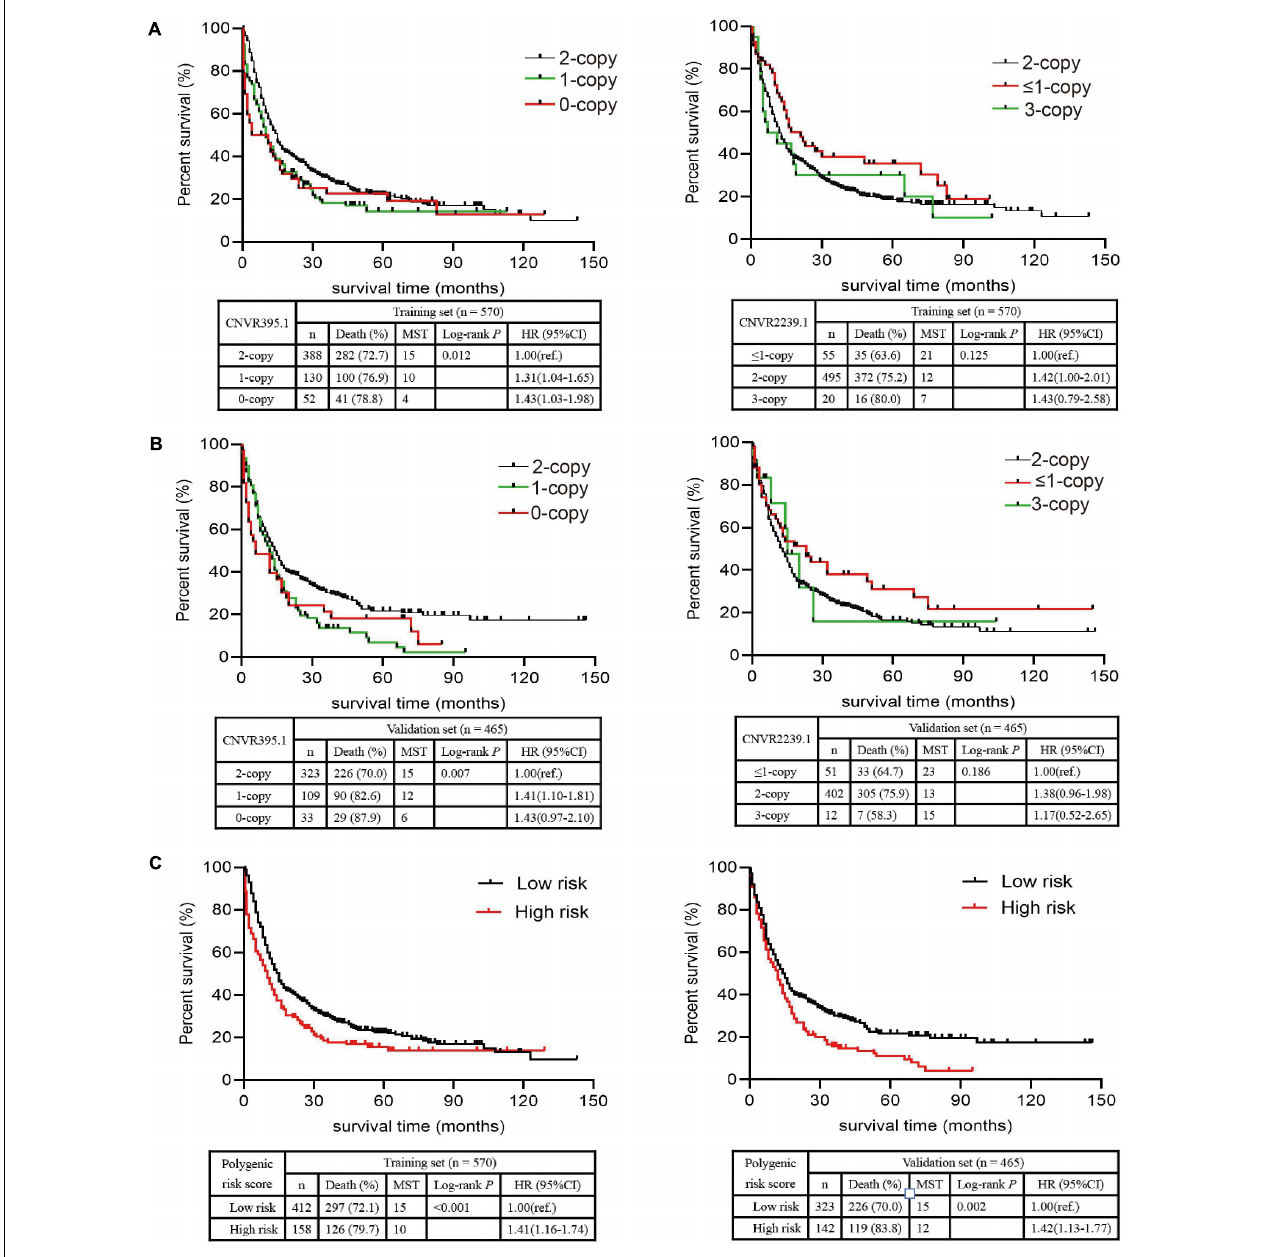
FIGURE 2 | Associations of the CNVR395.1, CNVR2239.1, and PRS with NSCLC OS in Chinese. (A,B) The Kaplan–Meier plot was used to visualize the survival probabilities for the CNVR395.1 and CNVR2239.1 in the training cohort (A) and the validation cohort (B) . (C) The Kaplan–Meier plot for PRS.